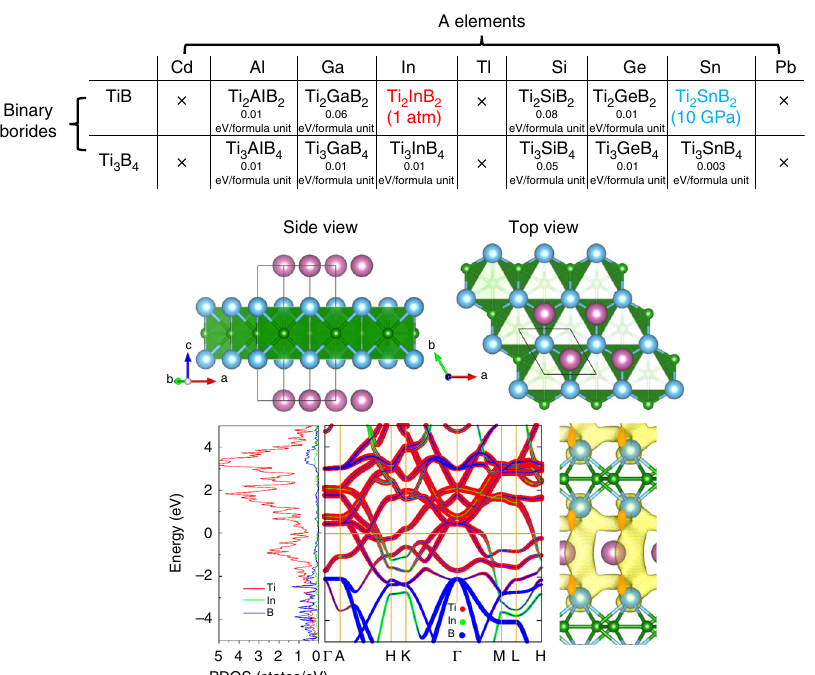
Fig. 2 Results of theoretical structure search. a Summary of structure search results using binary and ternary variable-composition methods, where the distances for metastable phases to the convex hull are labelled in the unit of eV per formula. b Crystal structure. c Calculated electronic structure for stable boron-containing ternary phase Ti 2 InB 2 . The projected density of states (DOS), projected band structure and partial charge map on the (110) plane ( − 0.5 eV < E − E f < 0.5 eV) for Ti 2 InB 2 are shown in the left, center, and right panels,